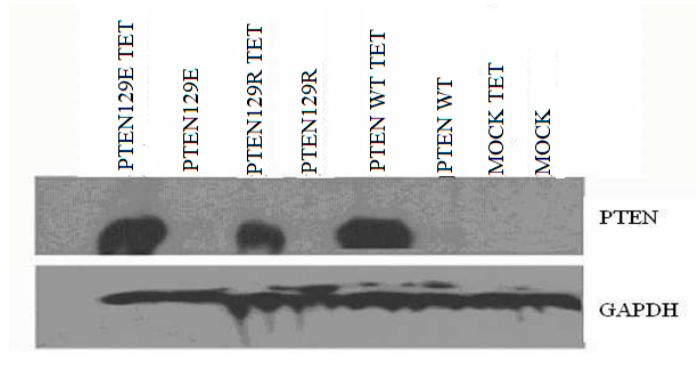
Figure 1. Expressions of PTEN on PC14 cells transfected with Mock, PTENwt, PTENG129R and PTENG129E vectors.